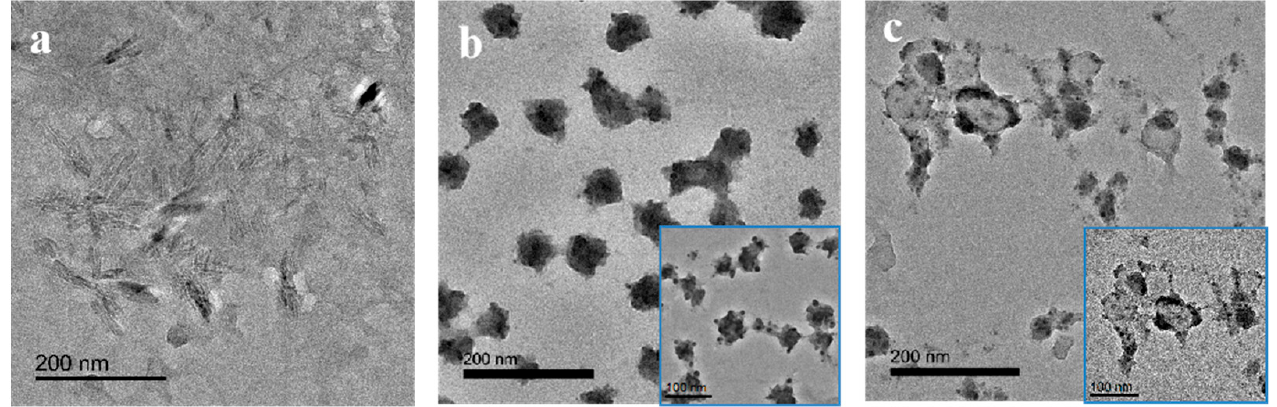
Figure 2. TEM images of ( a ) modified CNCs, ( b ) CSMs, ( c ) HMs. The inset shows the enlarged TEM images of corresponding samples.